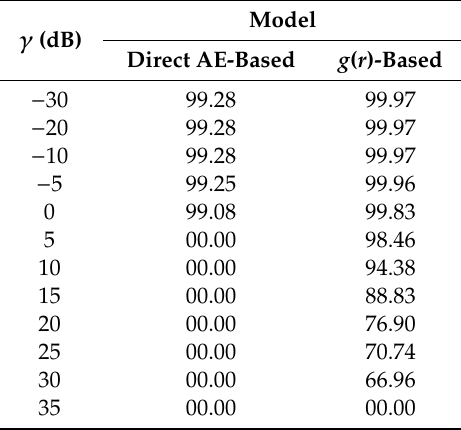
Figure 16. AE on channel 2 before / after adding noise. Table 12. Accuracy with added noise.